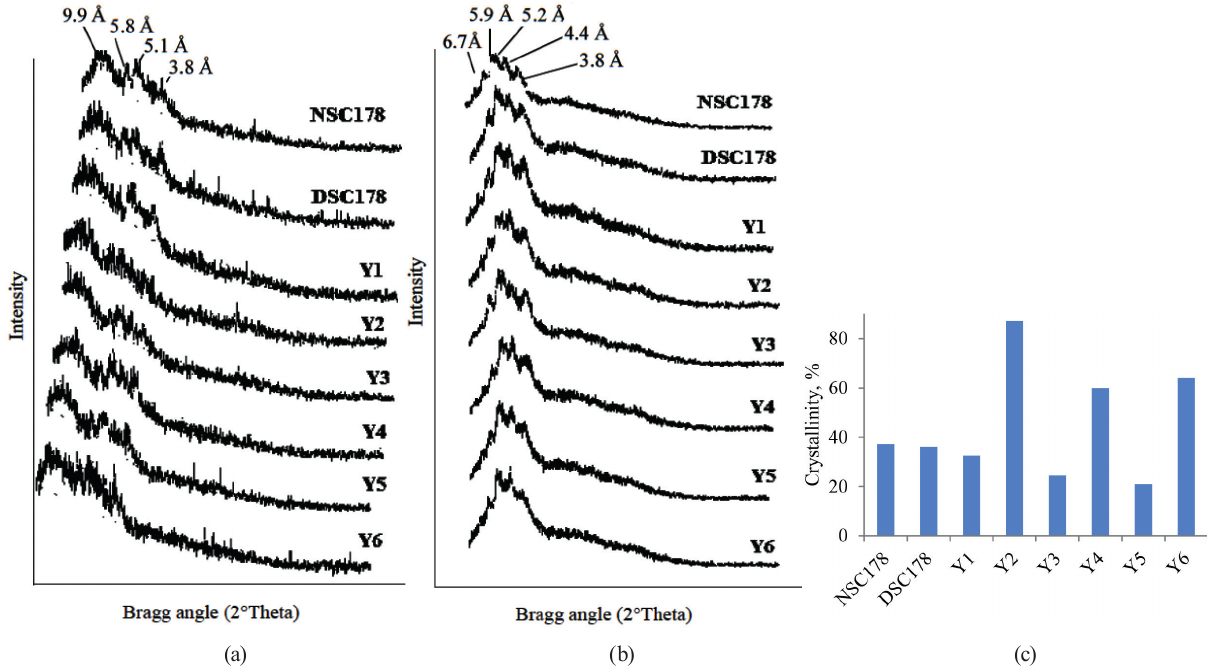
Figure 1 X-ray diffraction diagrams for raw corn samples (a) and nixtamalized corn samples (b), and crystallinity values for raw corn samples (c). NSC178 = Single Cross Giza 178 planted under normal conditions, DSC178 = Single Cross Giza 178 planted under drought conditions, Y1–Y6 = new yellow corn hybrids planted under drought